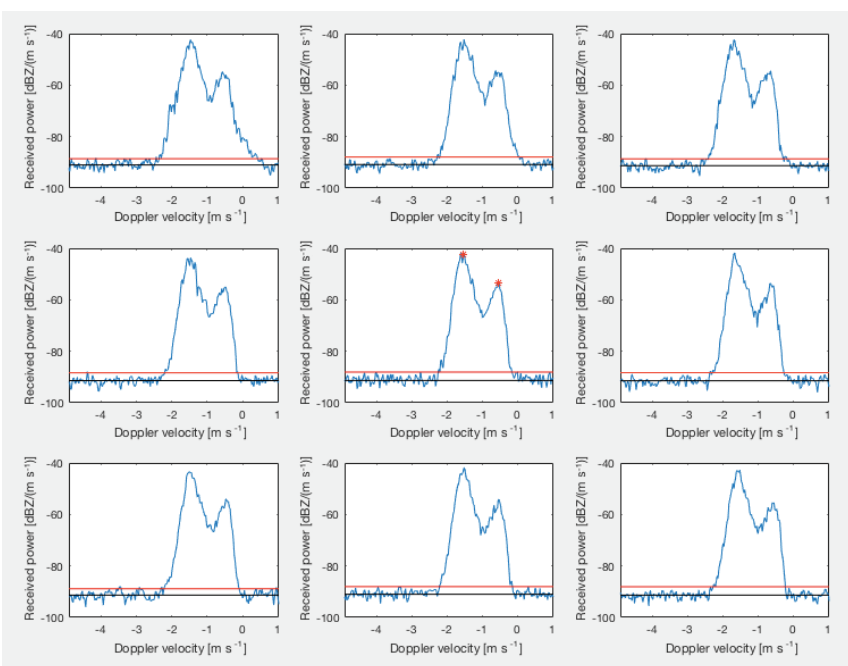
Figure 1. Example of graphical user interface for peak-marking by hand. For the Doppler spectrum in the center panel, two peaks (red stars) were marked by the user (HK). The surrounding panels display the spatially and temporally neighboring spectra. Data are as follows: KAZR spectra observed at TMP on 16 February 2014, 0.03–0.05UTC, between 1.0 and 1.2km height. The red line marks the maximum noise floor determined according to Hildebrand and Sekhon (1974), and the black line the mean of the noise. Table 1. Overview of the measurement periods used in each of the three data sets (first training data set, second training data set, testing data set) containing hand-marked peaks. Published studies of the selected periods, to which results can be compared, are noted as well. First training Second training Testing data set data set data set (comparison to